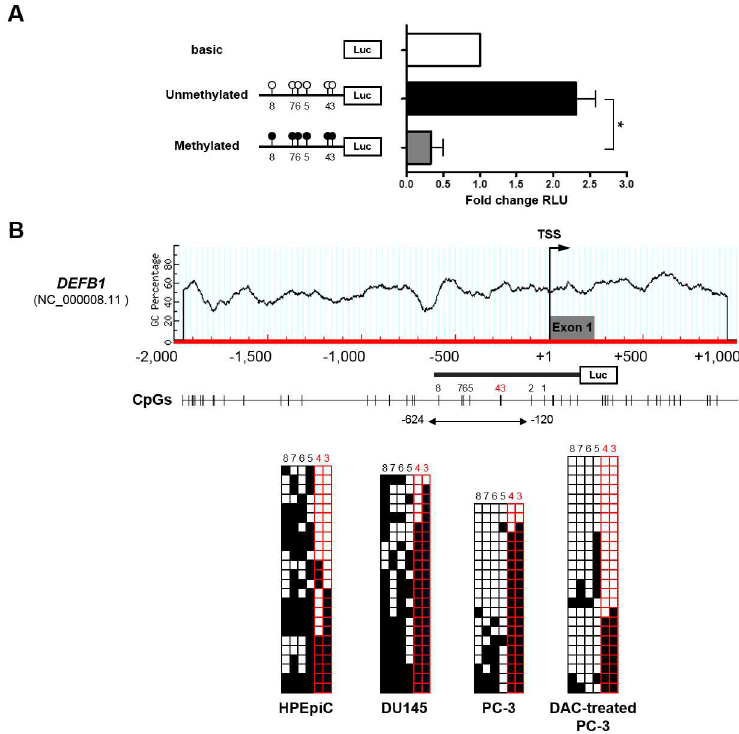
Fig 2. DNA methylation analyses of the low CpG-content promoter (LCP) of DEFB1 in prostate cancer cell lines. (A) Promoter reporter assay of the 5 0 -end regionof DEFB1 in HEK293T cells using the pCpGfree- basicLuciareporter plasmid. The synthesized fragment contained14 CpG dinucleotide sites (represented by lollipops). Of these, 8 CpGs were previously studiedand are not shown here. (B) Bisulfite sequencing analysis of the DEFB1 promoterharboringCpG 3 − CpG8 sites in prostate epithelial cell lines. Columnsrepresent singleCpG sites, and each row representsthe DNA sequenceof an individualclone. Unmethylated and methylatedCpG units are depictedas white and black boxes,